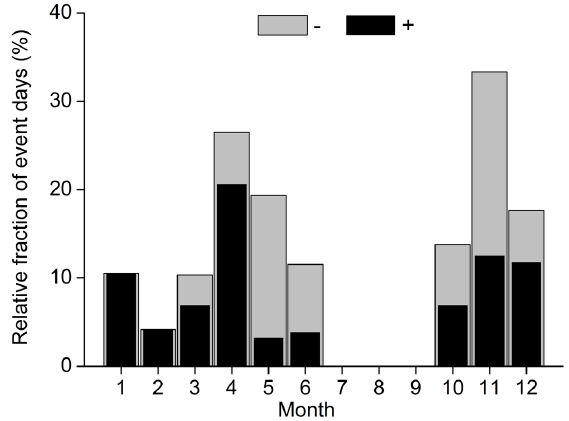
Fig. 6. Monthly relative fraction of night-time enhanced ion con- centrations event days for negative (grey bars) and positive (black bars)